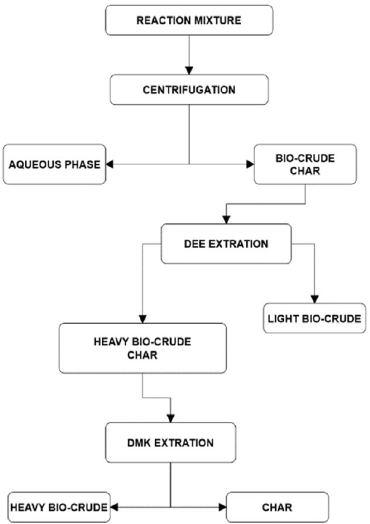
Figure 4. Procedure for separating the reaction